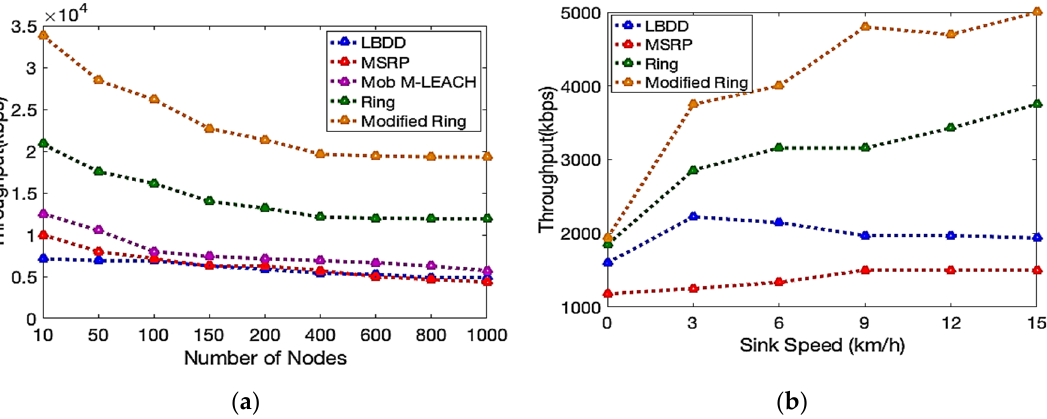
Figure 11. Throughput analysis; ( a ) variation in the network density; ( b ) variation in the sink